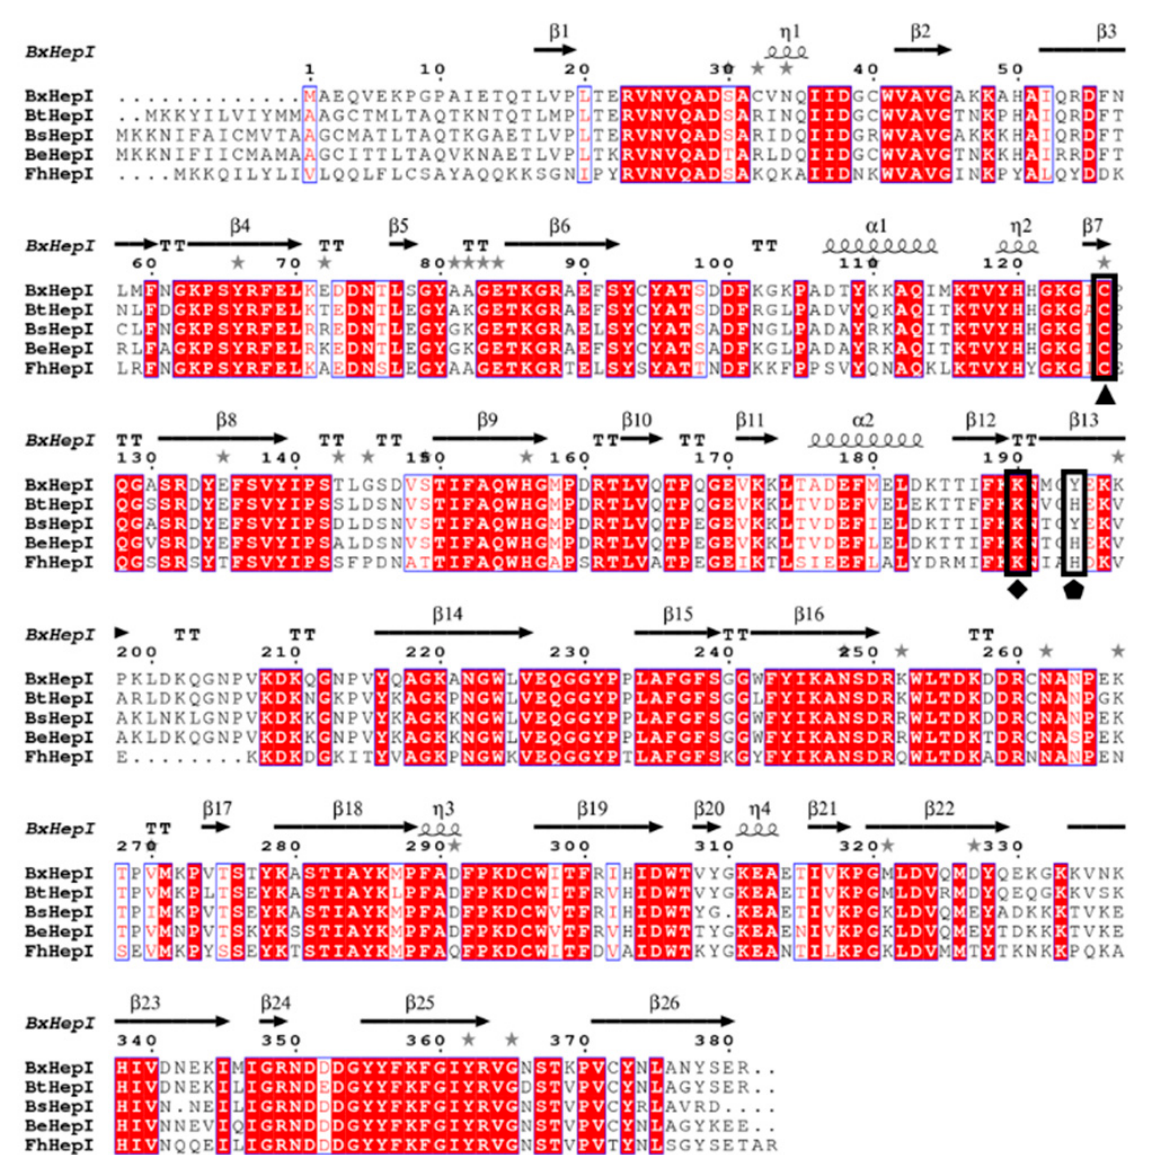
Figure 1. Multiple sequence alignment of heparinases I from B. xylanisolvens (BxHep-I), B. thetaiota- omicron (BtHep-I), B. stercoris (BsHep-I), B. eggerthii (BeHep-I), and F. heparinum (FhHep-I).